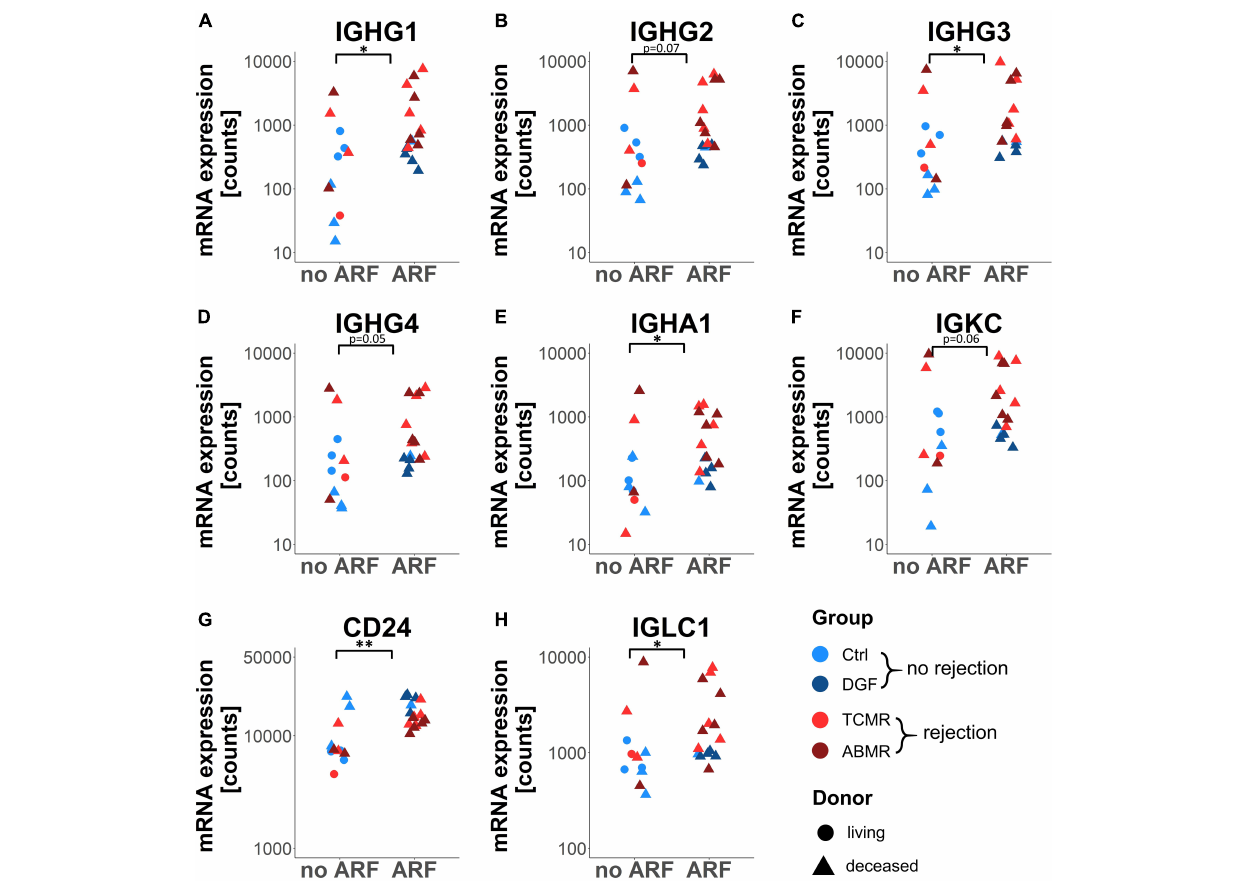
FIGURE 6 | Dot plot of eight selected genes differentially expressed between rejection and no rejection grouped according to the presence of acute renal failure (ARF). Dot plots showing gene expression of the genes IGHG1–4 (A–D) , IGHA1 (E) , IGKC (F) , CD24 (G) , and IGLC1 (H) in zero-time biopsies. ∗ p < 0.05; ∗∗ p <